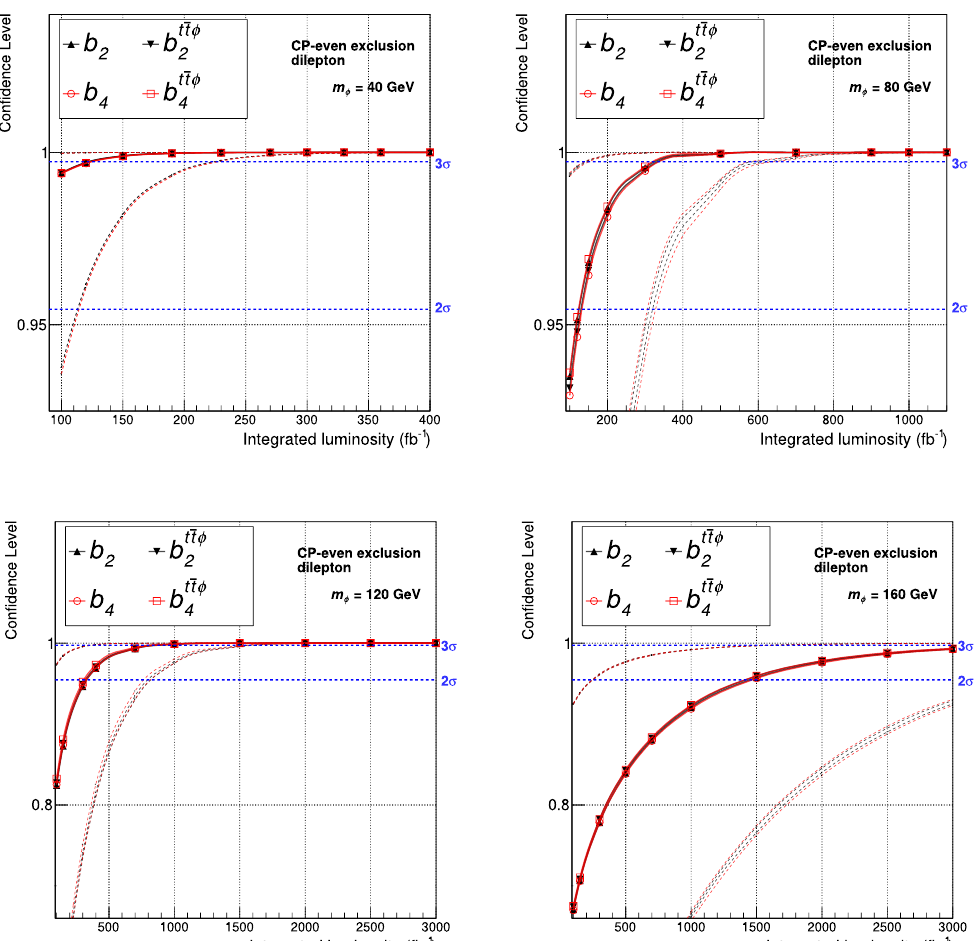
Figure 17. Expected CLs for CP-even exclusion assuming the SM (scenario 1), as a function of the integrated luminosity. The luminosity is increased until CL= 1 or L = 3000 fb (cid:0) 1 . Each plot represents a di(cid:11)erent (cid:30) boson mass. The vertical axis scale also changes, for visualization purposes. The red and black dashed lines represent the (cid:6) 1 (cid:27) bands for the variables considered. The blue dashed lines represent the 2 (cid:27) or 3 (cid:27) CL lines.